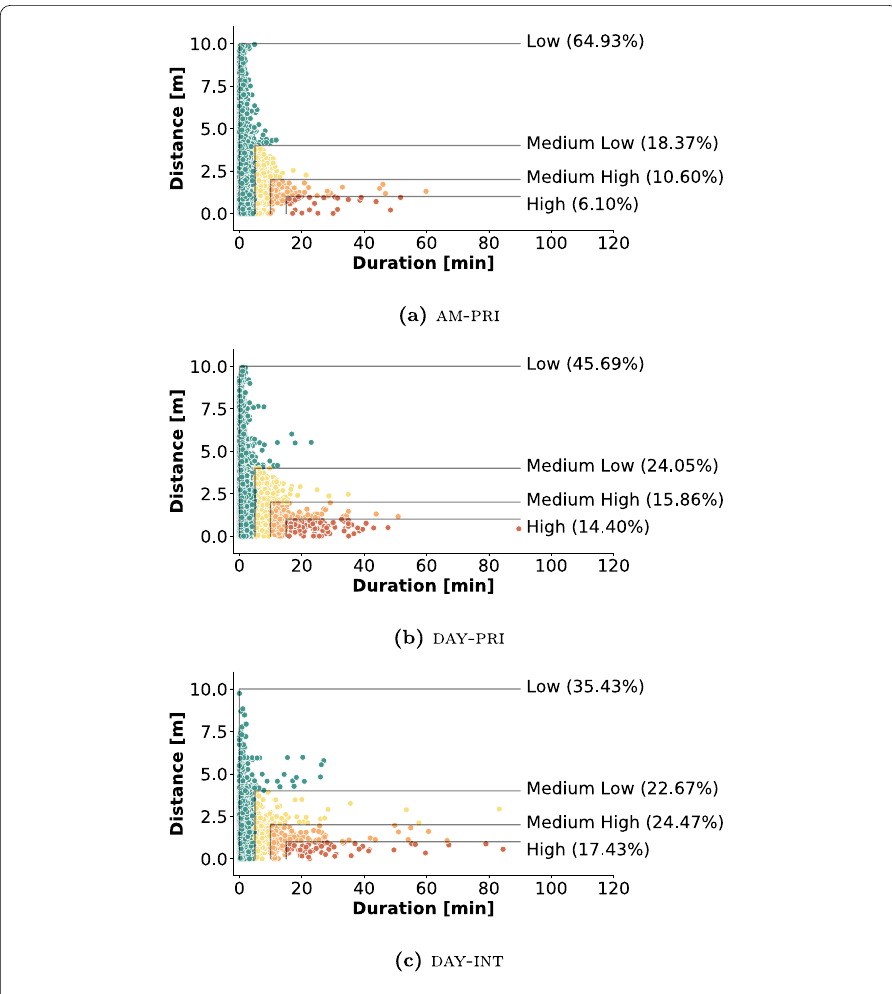
Figure 4 Summer camp contacts and contagion risk. The figure reports, for each summer camp, the corresponding contacts classified according to their risk of contagion as a function of the duration of exposure and proximity, following the risk categories in Table 4. The values in parentheses denote the percentage of time spent in a contact with the corresponding risk category